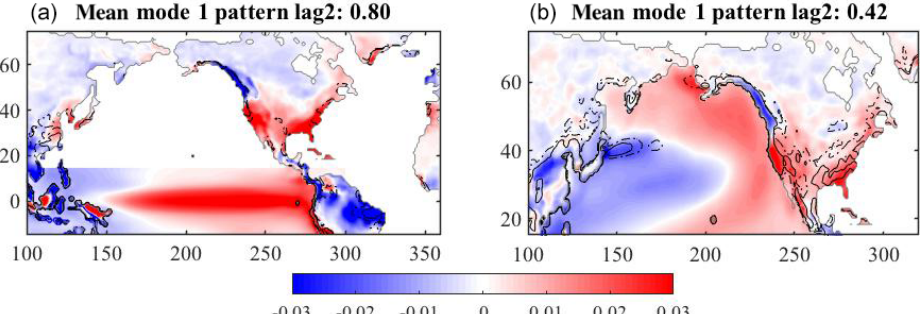
Figure 11. Same as Fig. 6, except for representing the covariance between (a) the tropical Pacific 25m ocean temperatures and land precip- itation at a lag of 2 months and (b) the North Pacific 25m ocean temperature and land precipitation at a lag of 2 months.